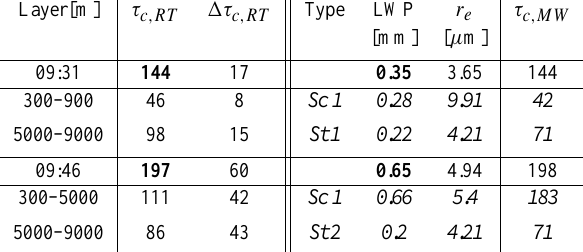
Table 3. Results for the cloud optical thickness from the fit of the transmissions with the 1-D RT model (left half) and from the LWP measurements (right half). For the RT model, asymmetry factors of 0.85 and 0.7 were used for the lower and upper layer, respectively